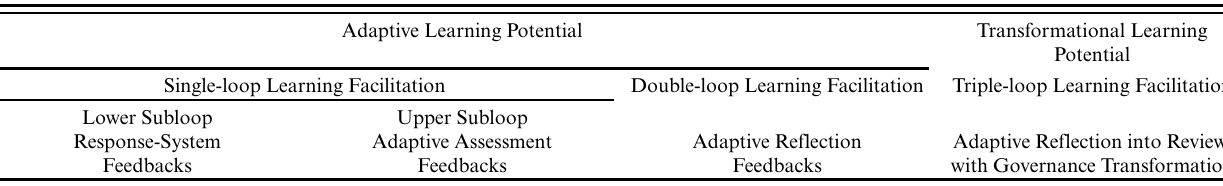
Table 2 . Learning potentials in the Strategic adaptive management (SAM) Reflexive Learning Framework (SRLF). A functional description of the SAM cycle nested feedback system, demonstrating explicitly where and when to implement more immediate responses, adaptive assessment, adaptive reflection, and review with governance transformation. These feedbacks facilitate and guide single-, double-, and triple-loop learning in the SRLF, ultimately for activating, completing, and then regenerating the SAM